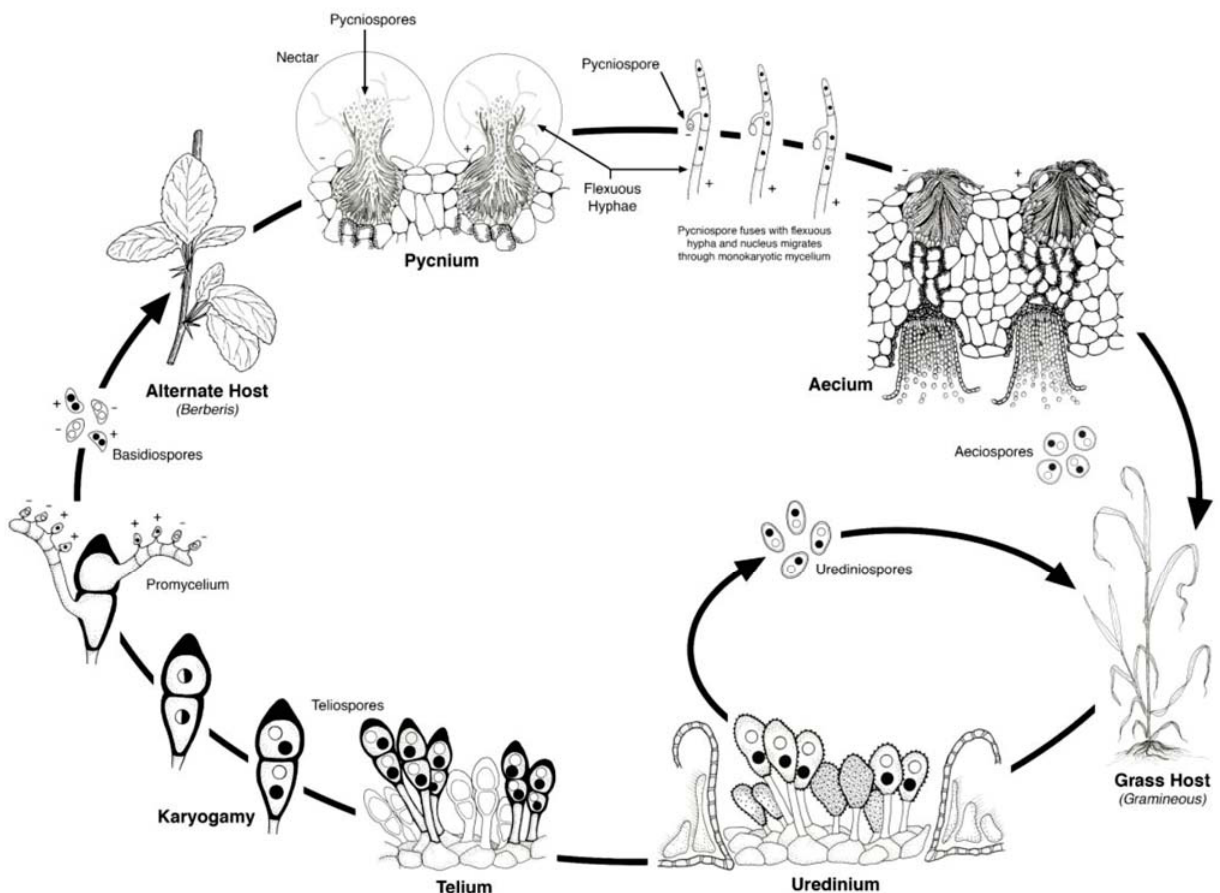
Figure 2. Life cycle of a heteroecious, macrocyclic cereal rust. The alternate host for stem rust — Puccinia graminis is Berberis vulgaris (barberry); for leaf rust — Puccinia triticina , Thalictrum speciosissimum (meadow rue); for crown rust — Puccinia coronata , Rhamnus cathartica (buckthorn). Illustration by Jackie Morrison,